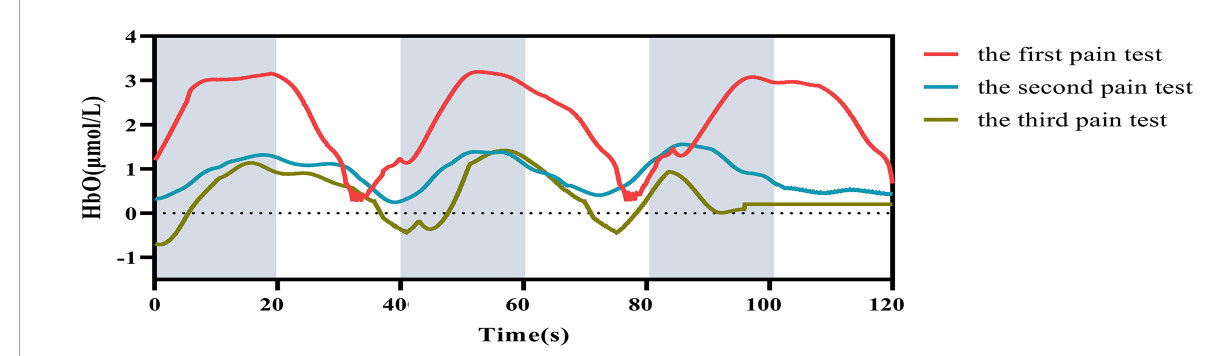
FIGURE4 Time series of changes in mean HbO concentrations for three pain tests. The solid line indicates the average of the concentrations, red indicates the first pain test, blue indicates the second pain test, and green indicates the third pain test. The shaded part indicates the pain stimulation task, which lasted 20